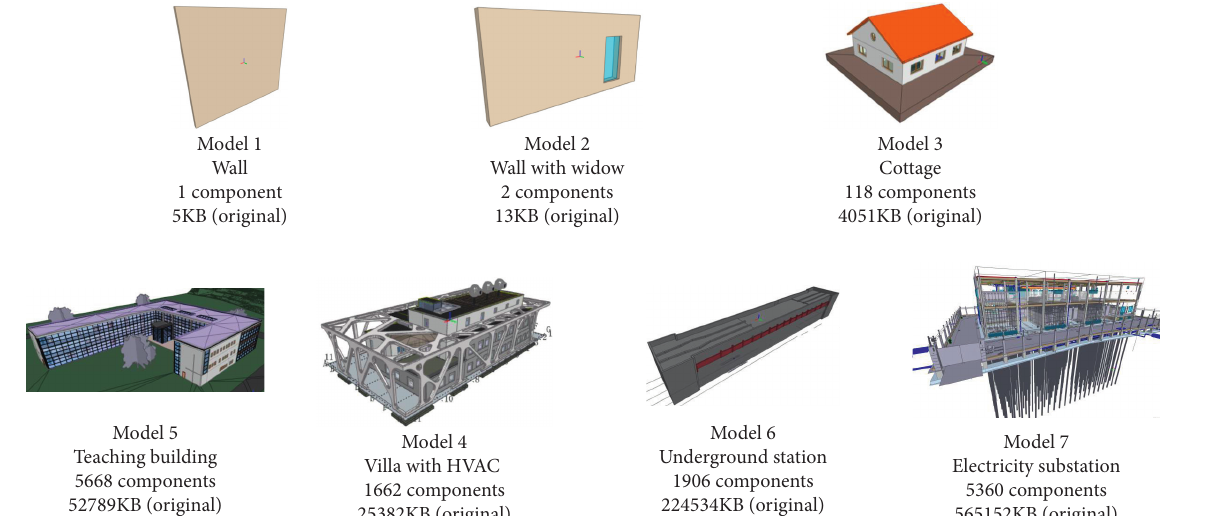
Figure 19: Detailed information of 6 test model cases in